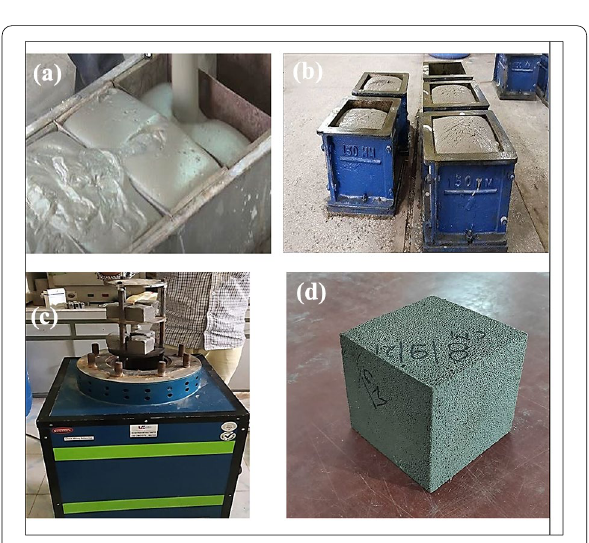
Fig. 15 Laboratory preparation of light weight concrete. a Pouring of mix; b expansion of mix; c autoclaving of AAC blocks and d developed AAC